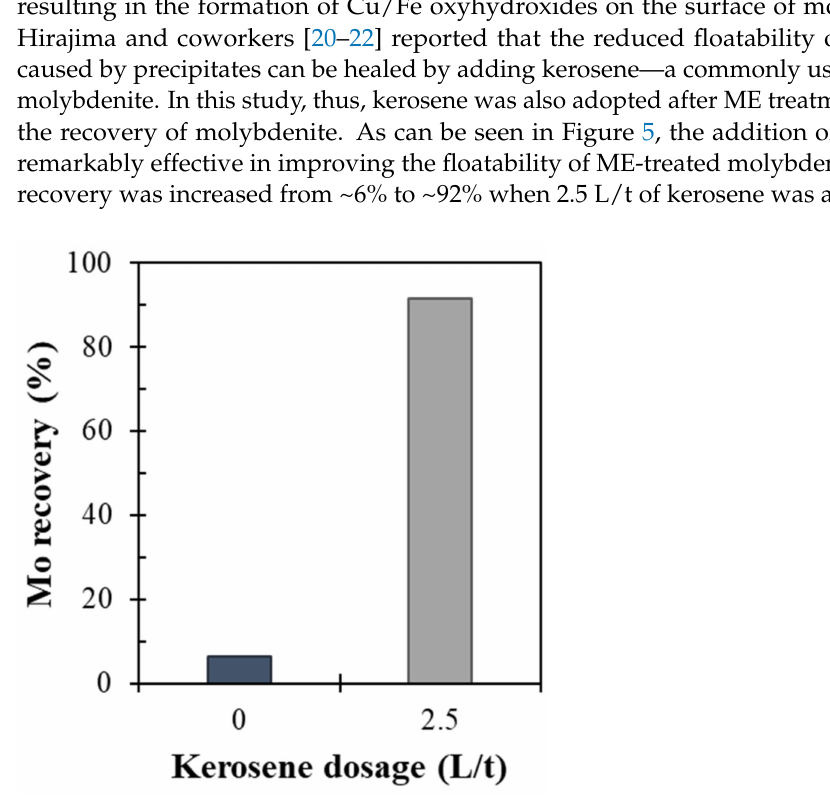
Figure 5. Effect of kerosene dosage on the floatability of ME-treated